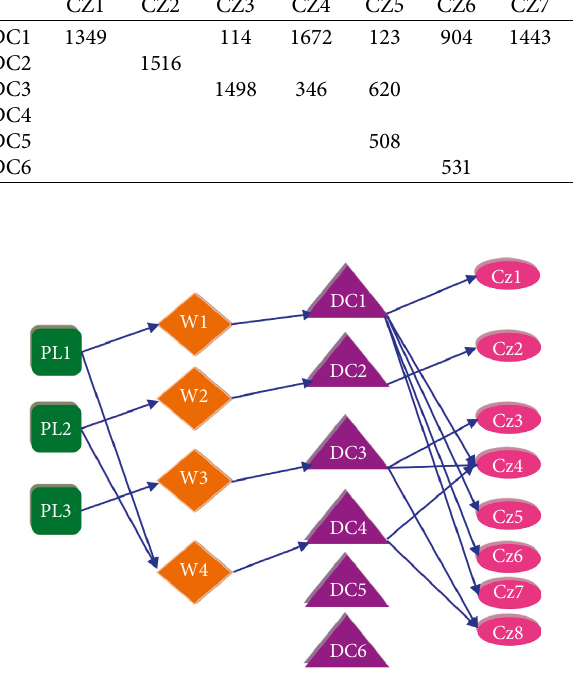
Figure 4: Network structure for the complete model in year 1 and for the developed model with new financial aspects.